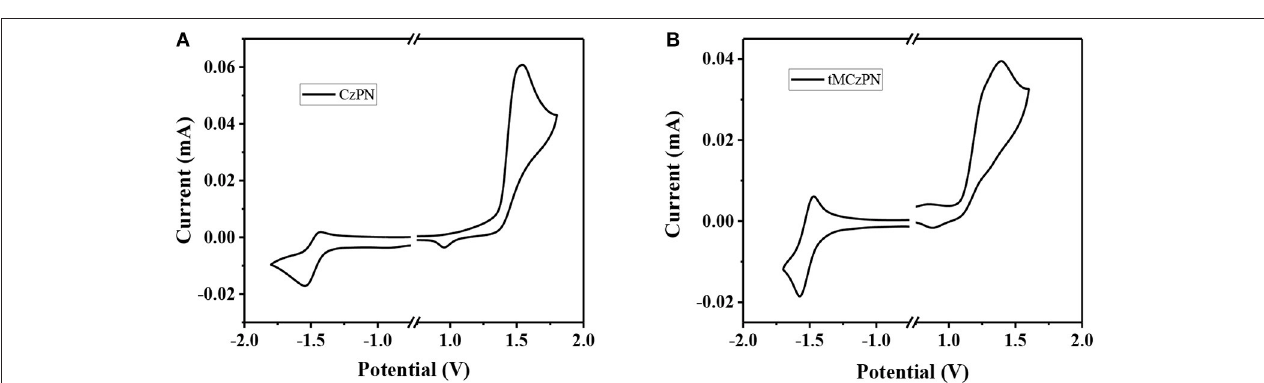
FIGURE 2 | Cyclic voltammograms of (A) CzPN and (B) tMCzPN in DMF recorded with a scan rate of 0.05 V/s. The HOMO and LUMO levels are calculated with the equation: HOMO = – e ( E ox + 4.56), LUMO = – e ( E red + 4.56). E ox , E red are the onsets of oxidation and reduction curves.